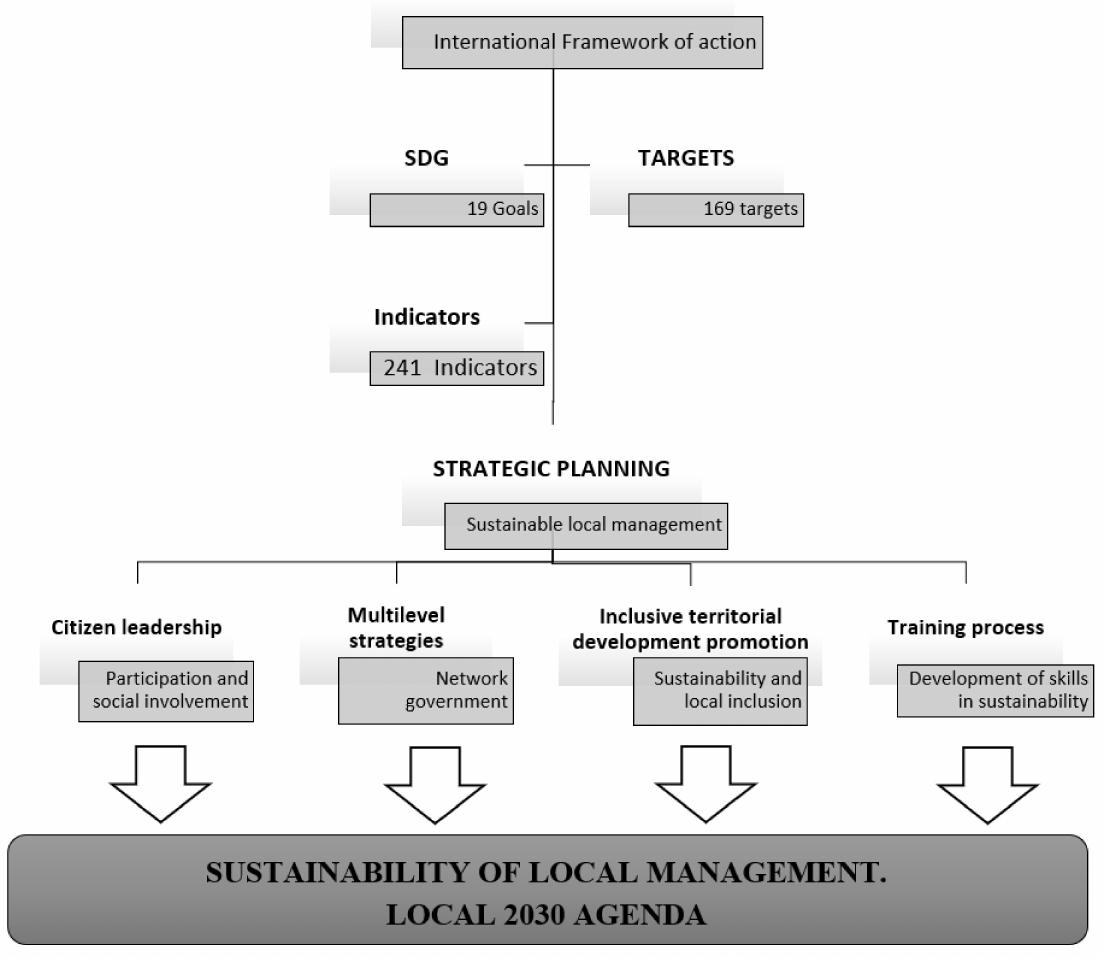
Figure 1. Principles of sustainable local management for a Local 2030 Agenda (L2030A). SDG, Sustainable Development